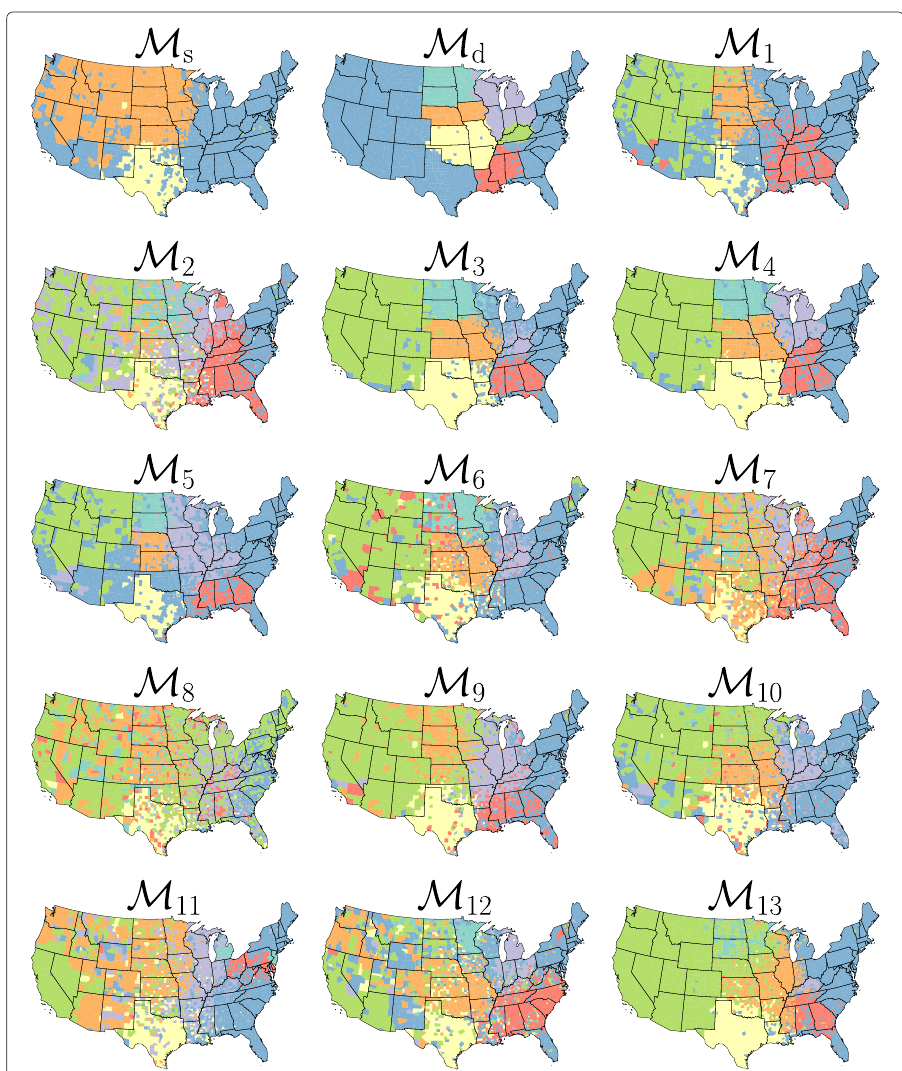
Fig. 20 Weighted structural motif-based clusterings of the US-M IGRATION network, for all motifs on at most three nodes. Each county (node) is colored by its cluster allocation